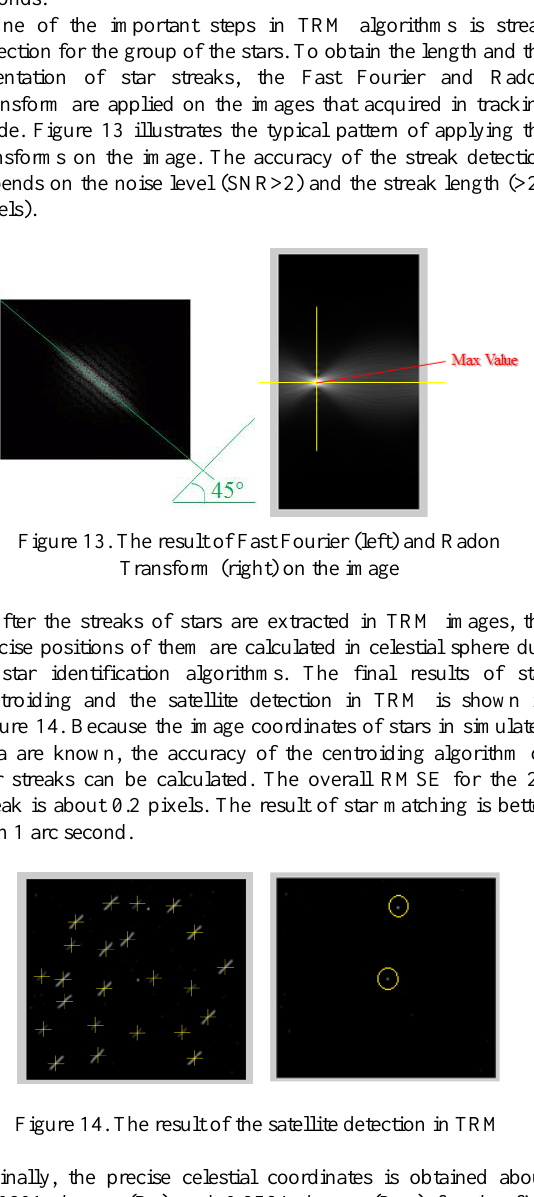
Figure 14. The result of the satellite detection in